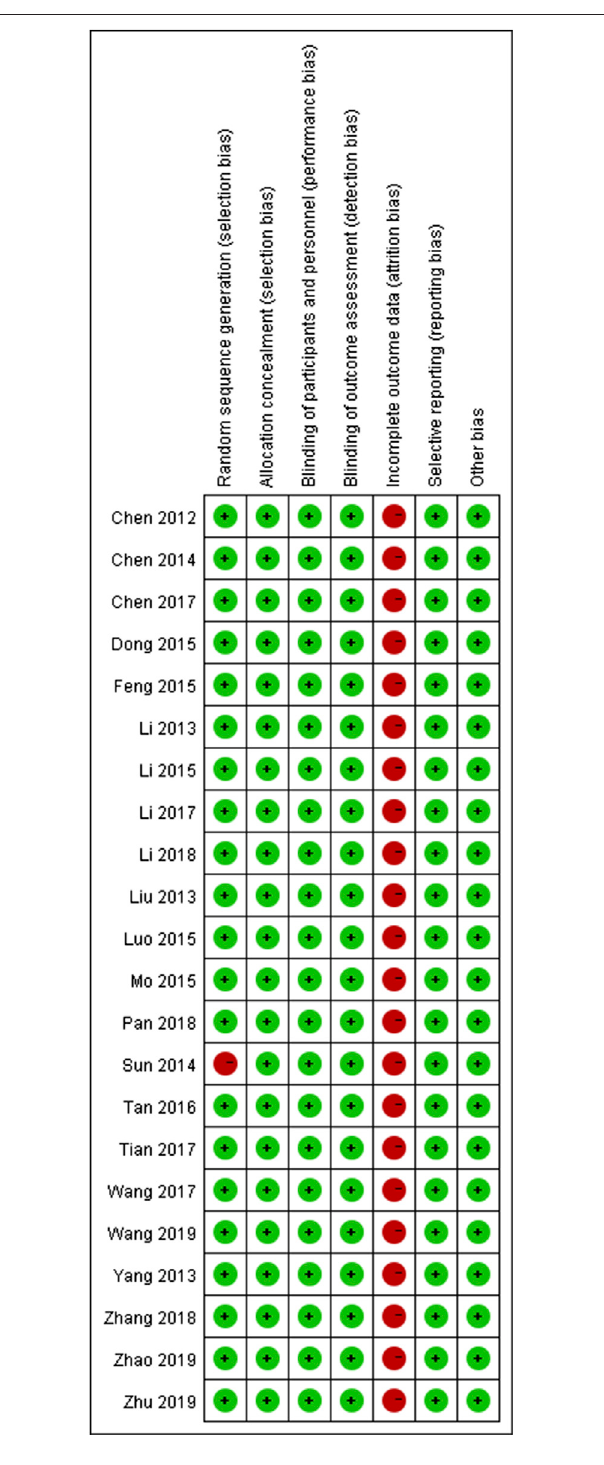
FIGURE 2 | Risk of bias assessments within